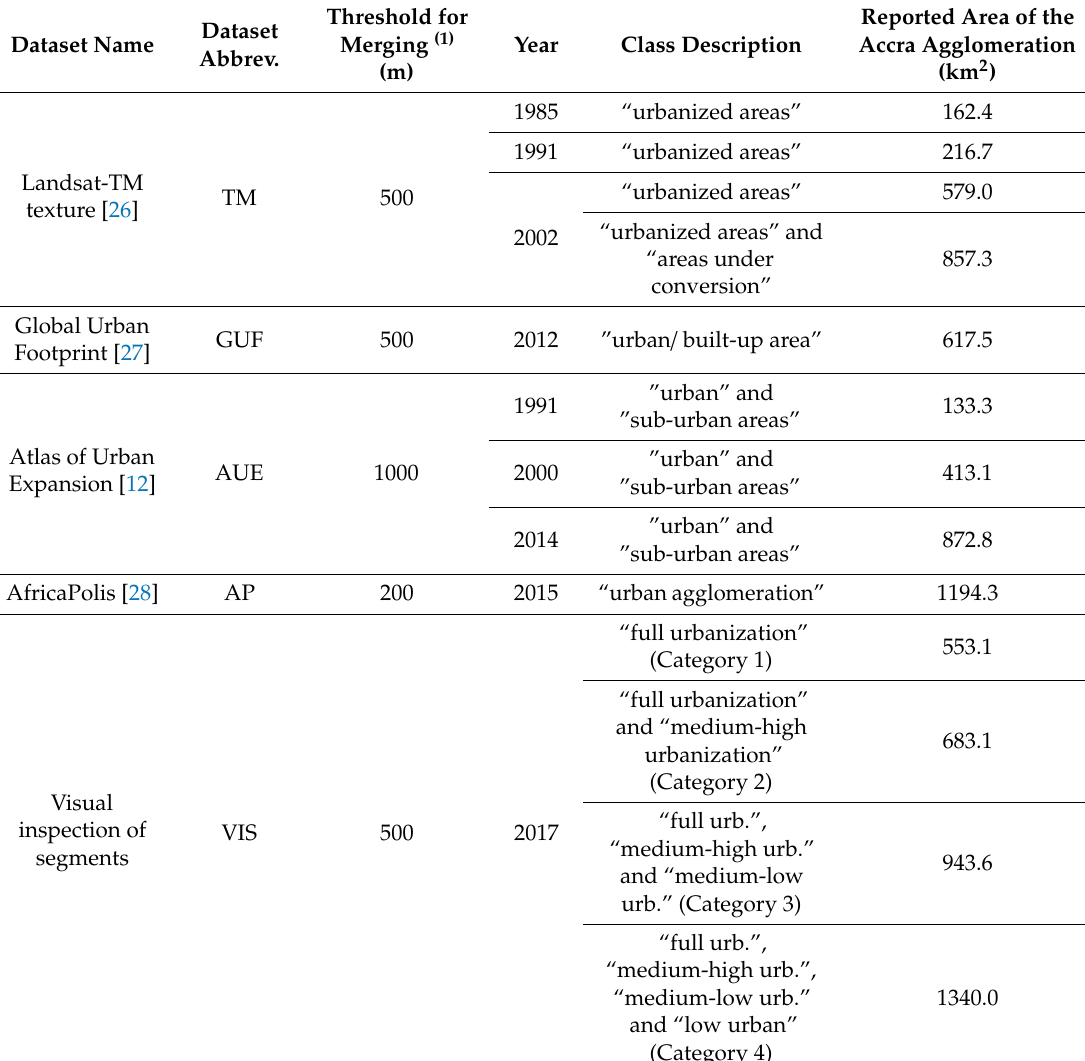
Table 1. List of the nine compared maps with computed agglomeration size for the Accra area and names of the datasets from which they origin. (1) The “threshold for merging” indicates the maximum distance applied for including neighboring urban areas within the